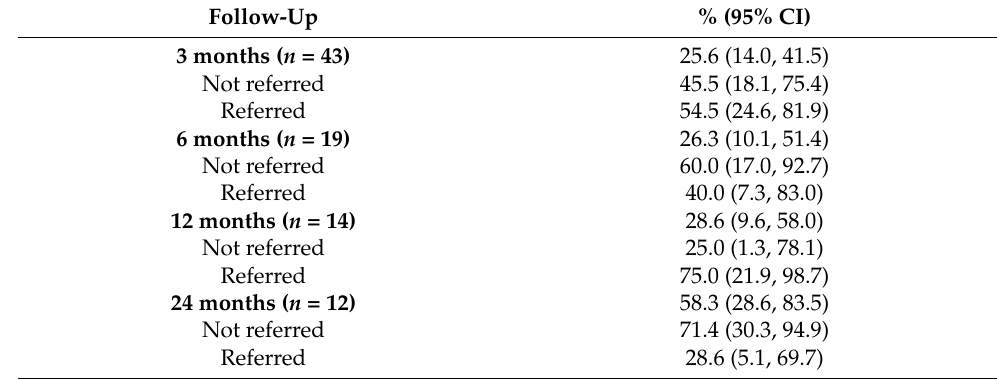
Table 4. Percentages of newly diagnosed LE patients with self-reported signs and